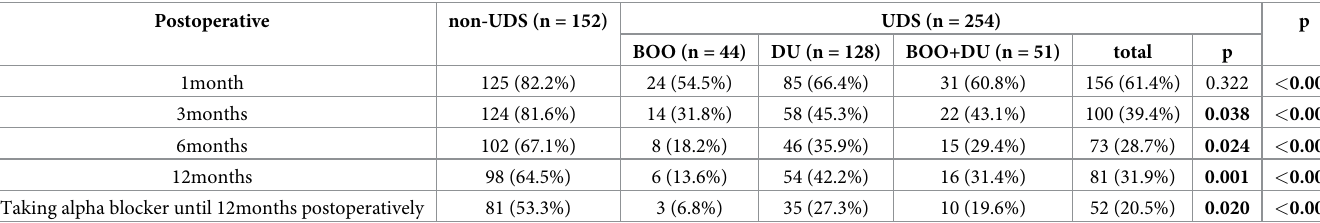
Table 3. Comparison between rate of alpha blocker use postoperatively depending on urodynamic outcomes. Postoperative